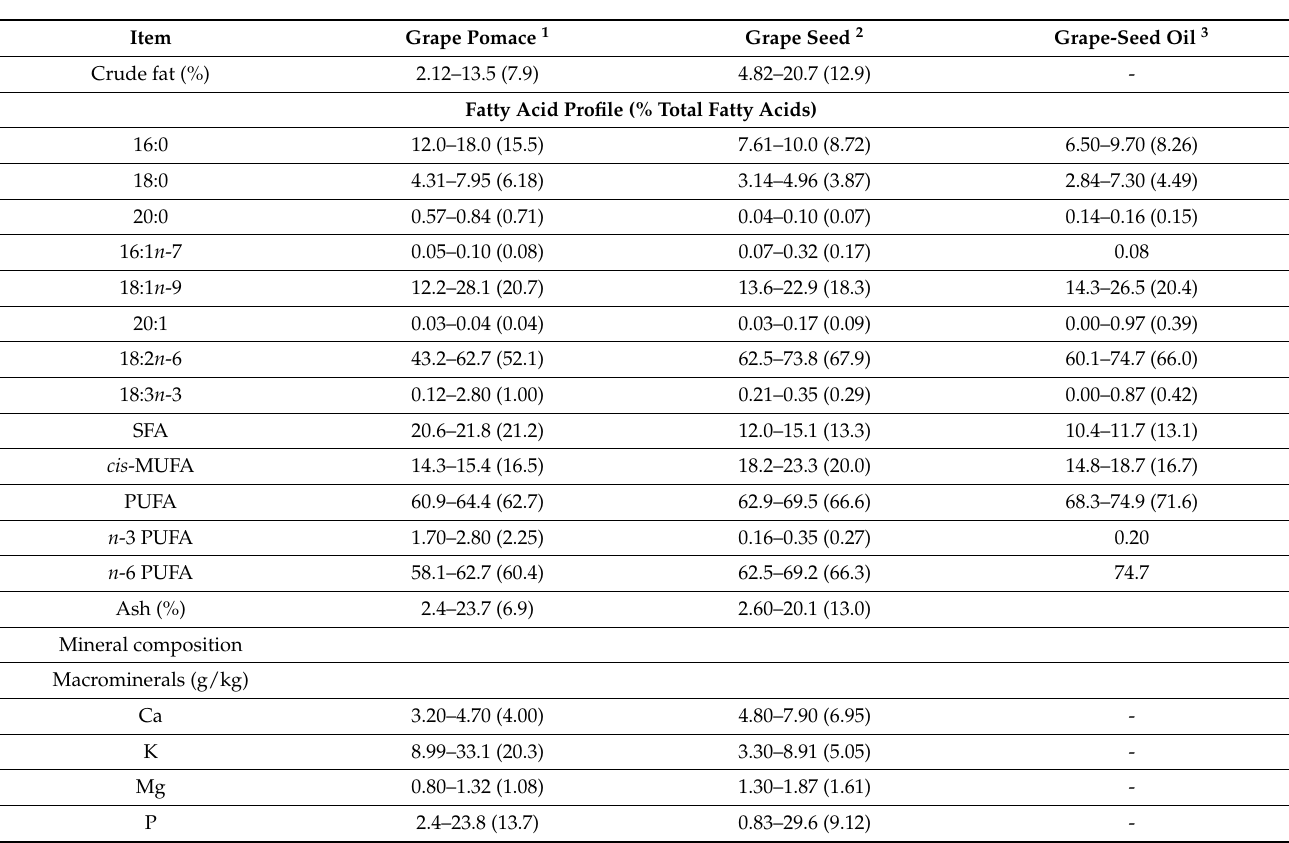
Table 2. Lipid content and fatty acid profile, and ash, mineral, vitamin E, and phenolic compound content of the main grape by-products (values are expressed on a dry weight basis, w/dw, hyphenated values are